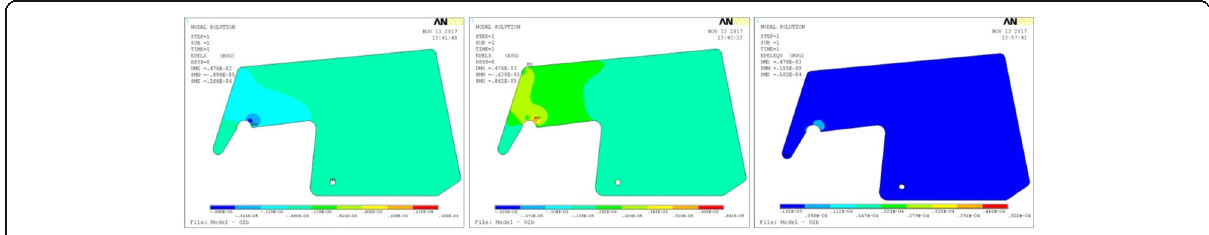
Fig. 5 Maxillary strain in X and Y directions and total